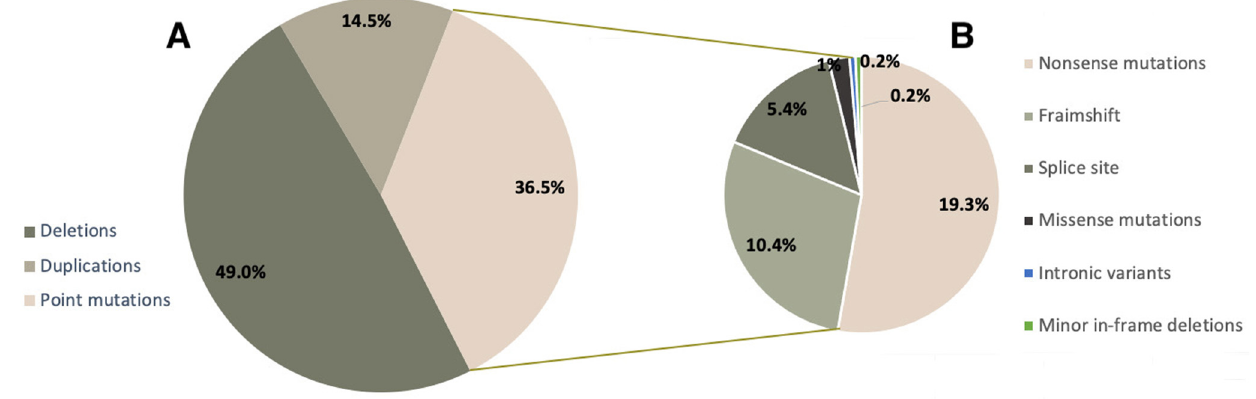
Figure 1. Mutation spectrum of the DMD gene in Russian patients.